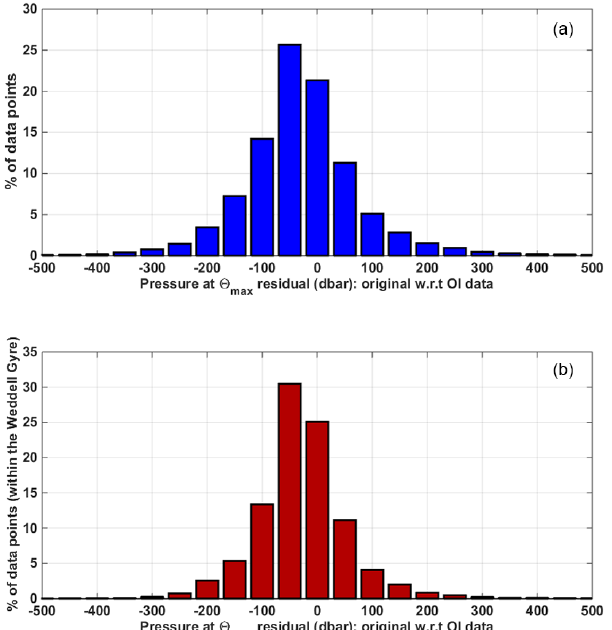
Figure 19. The percentage of data points binned by pressure resid- uals (dbar) at the level of the sub-surface temperature maximum, where the float data objectively mapped to the profile locations are subtracted from the original profile data points, for (a) the entire data set and (b) for those data points within the defined Weddell Gyre region only.